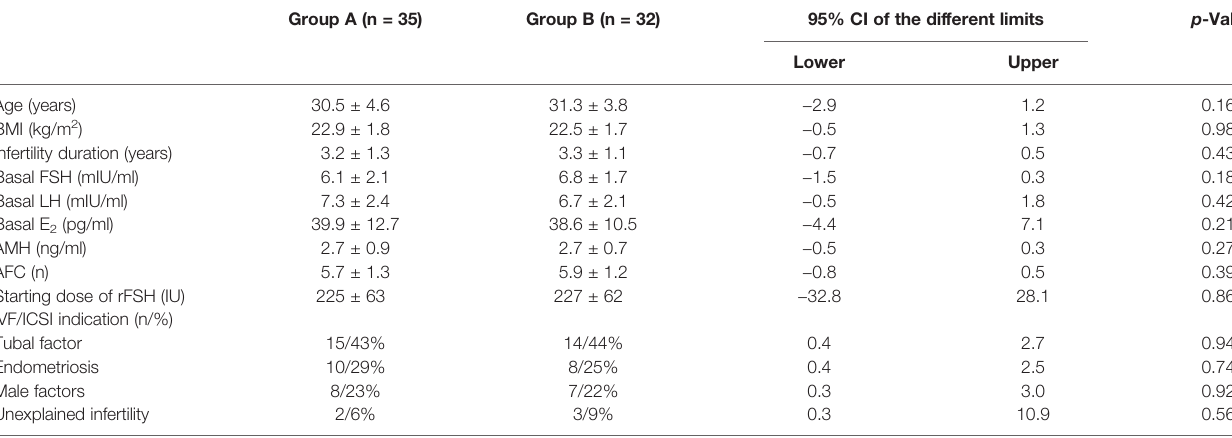
TABLE 1 | Comparison of baseline characteristics of patients in group A and group B. Group A (n = 35) Group B (n = 32) 95% CI of the different